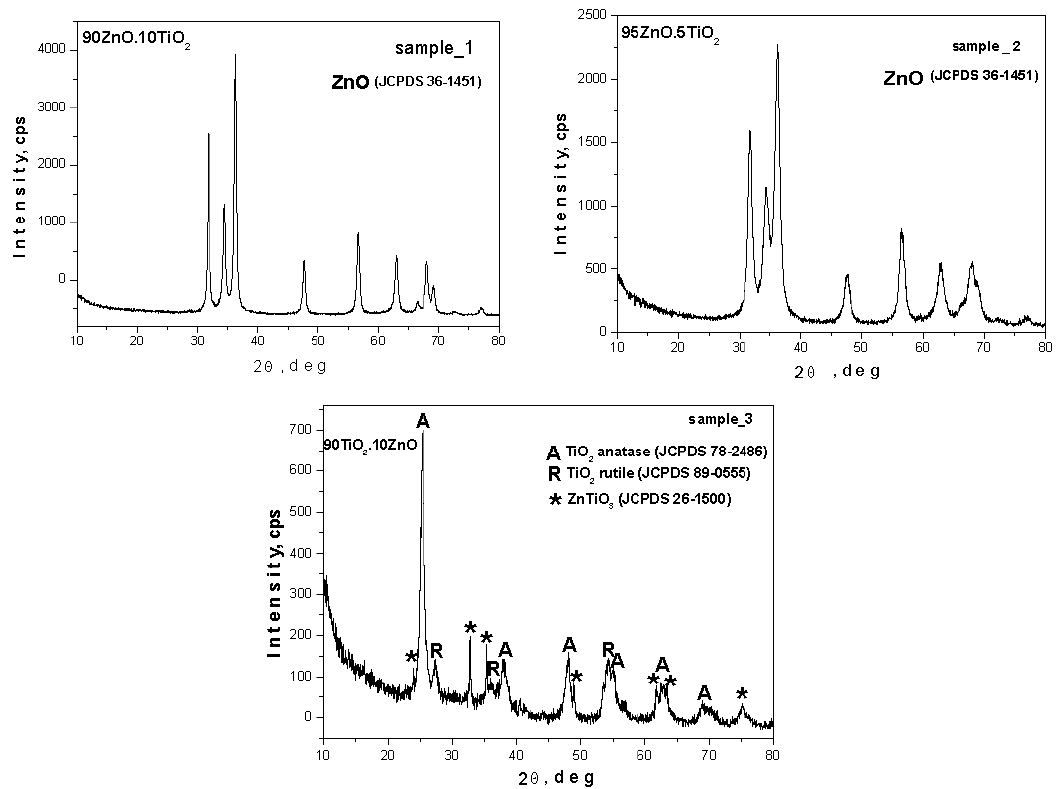
Figure 2. XRD patterns of the investigated samples 1, 2 and 3.